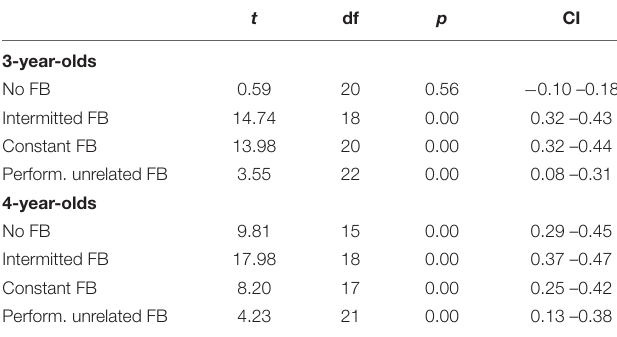
TABLE 3 | Accuracy performance tested against